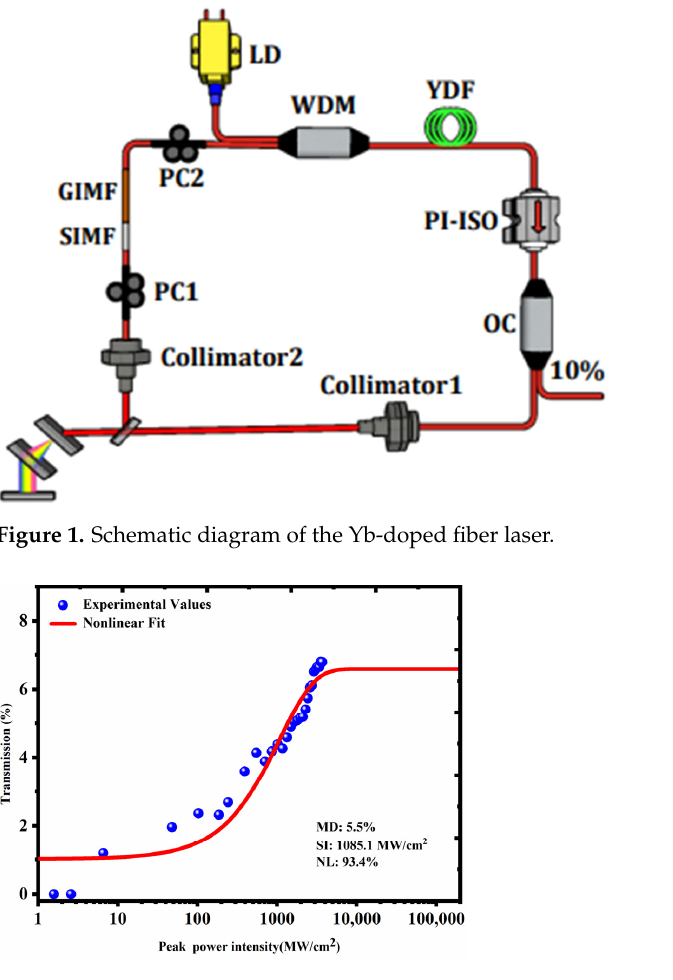
Figure 2. Nonlinear transmission curve of the SIMF-GIMF structure as SA. SI: saturation fluence; NL: non ‐ saturable loss.